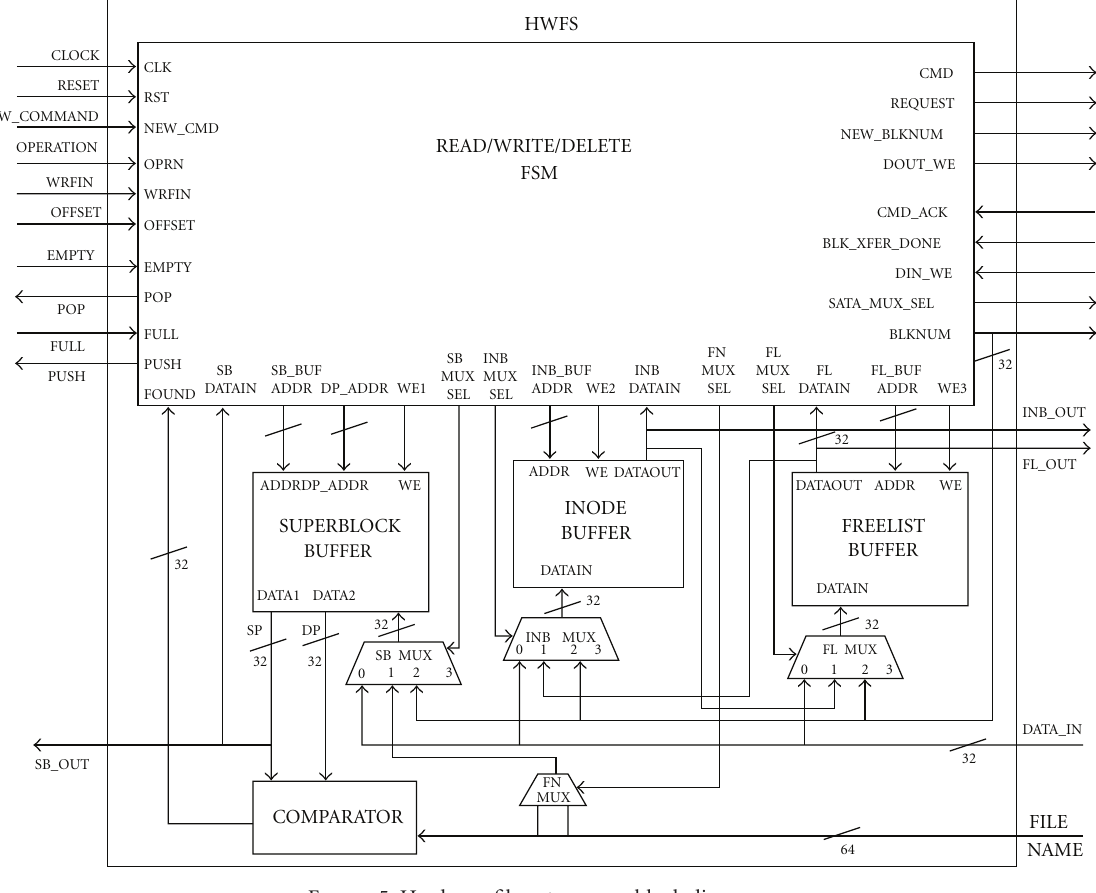
Figure 5: Hardware filesystem core: block diagram.